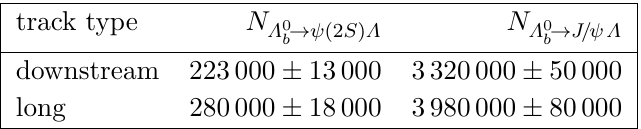
! (2 S ) (cid:3) and (cid:3) 0 ! J= (cid:3) signal decays from the (cid:12)t to b b